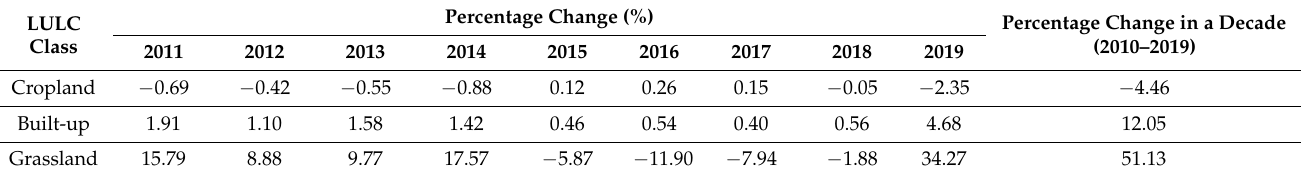
Figure 4. The Land use land cover distribution depicts three main classes: Cropland, Built-up, and Grassland: ( a ) 2010 and ( b ) 2019. Table 3. Percentage change in the area of LULC classes from